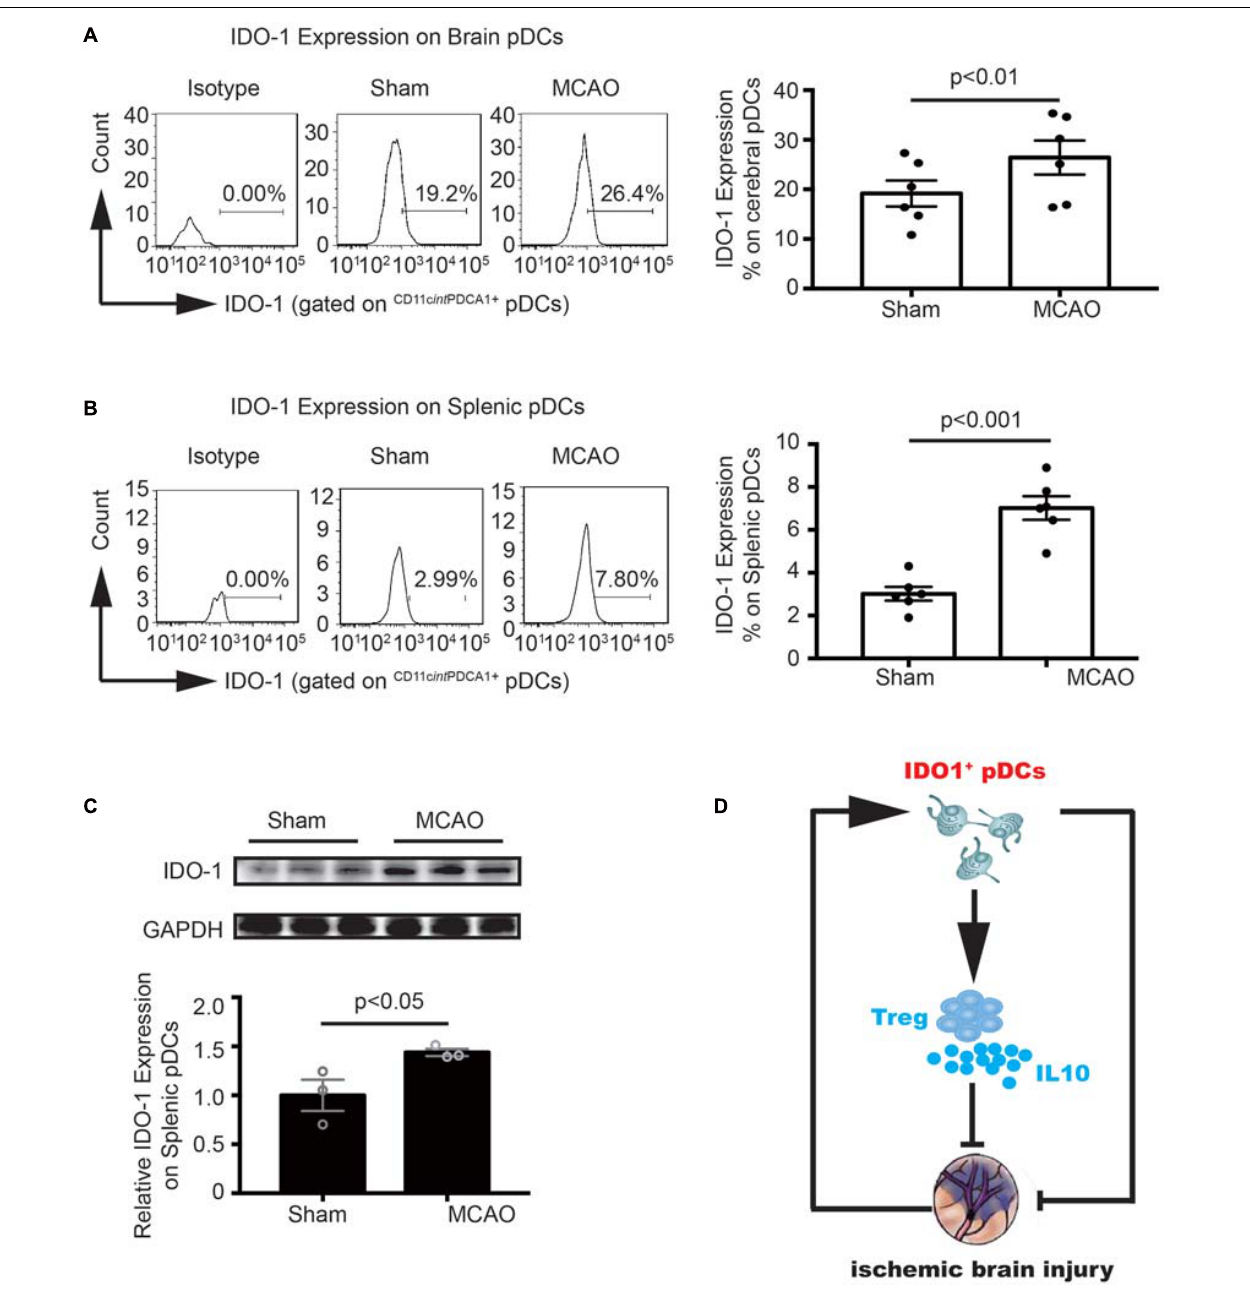
FIGURE 6 | MCAO increased the Indoleamine 2,3-dioxygenase 1 (IDO1 expression on pDCs. Brain ischemia was induced by 45 min MCAO. Sham-operated animals underwent surgical exposure of the right middle cerebral artery without occlusion. The brain and spleen samples were collected at 2 days after MCAO. IDO1 expressions on pDCs from the brain (A) and spleen (B) were analyzed with Flow cytometry. Isotype controls (left), representative flow cytometric images from each group (middle) and corresponding statistical analysis (right) were shown. Indicated numbers are the mean percentages of IDO1 + pDCs. Data are expressed as means ± SEM for n = 6 mice per group. (C) The protein levels of IDO1 were detected with Western blot analysis. Representative Western blots were shown (above). The intensity of protein bands was quantified and shown as the ratio to sham after normalization by GAPDH (below). The results are expressed as mean ± SEM for three independent experiments. The scatter plots represent independent samples. (D) Schematic illustration of IDO1 + pDCs-regulated protection against MCAO-induced brain injury and its association with activation of Tregs.